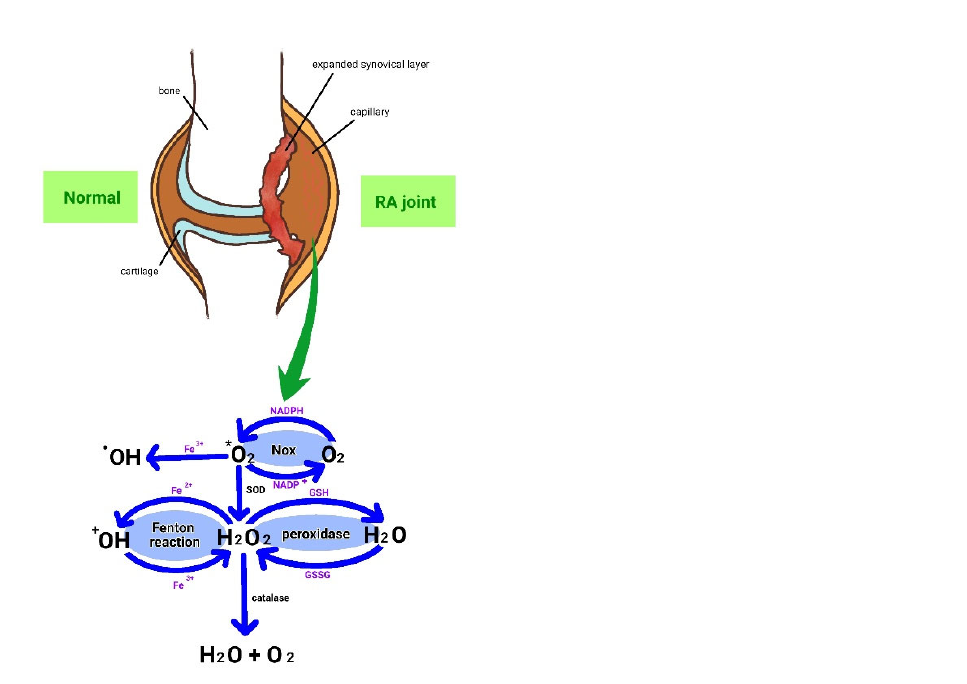
Figure 1. Bone and joint damage and the generation of reactive oxygen species in an inflamed joint affected by rheumatoid arthritis. Abbreviations: RA, rheumatoid arthritis; GSH, reduced glutathione; GSSH, oxidized glutathione; NADPH, nicotine amide adenine dinucleotide phosphate; SOD, superoxide dismutase.